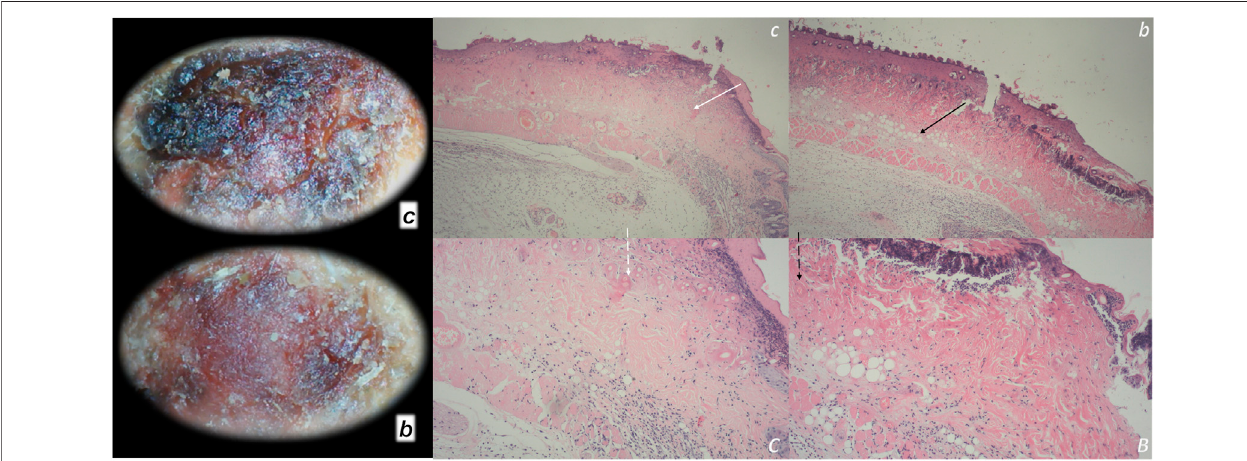
FIGURE 1 | Burn skin lesions in mice and BPC 157 therapy effect. The effects of the gastric pentadecapeptide BPC 157 were investigated on deep partial skin thicknessburns(1.5 × 1.5 cm)covering20%ofthetotalbodyarea,whenadministeredtopicallyorsystemicallyinburnedmice(Mikusetal.,2001).Characteristicwound presentation at one week after injury, grossly, the poor healing in the untreated control or mice treated with vehicle only ( c (black letter) ) was completely reversed in BPC 157 cream – treated mice ( b (black letter) ) (1 μ g/g neutral cream thin layer once time daily). Likewise, BPC 157 mice exhibited an increased breaking strength and relative elongation of burned skin and reduced water content in burned skin. Contrarily, silver sulfadiazine regimen did not achieve these healing effects. Microscopically (lower) , at the postinjury day 3, in control mice, the burned area exhibits severe edema in the dermis and subcutis as well as an exudate with abundant edematous fl uid on the surface (white arrow). Coagulated blood vessel walls and a proportion of vessels with fi brin clots (dashed white arrow) (HE, x4 ( c ), x10 ( C )). Contrarily, BPC 157 mice have much less pronounced edema (black arrow), weak cellular in fi ltrate, and exudate, and the blood vessels walls seem to be more preserved (dashed black arrow) and in more vessels, endothelial cell can be observed. Almost no arterial clots (HE, x4 ( b ), x10 ( B )) were